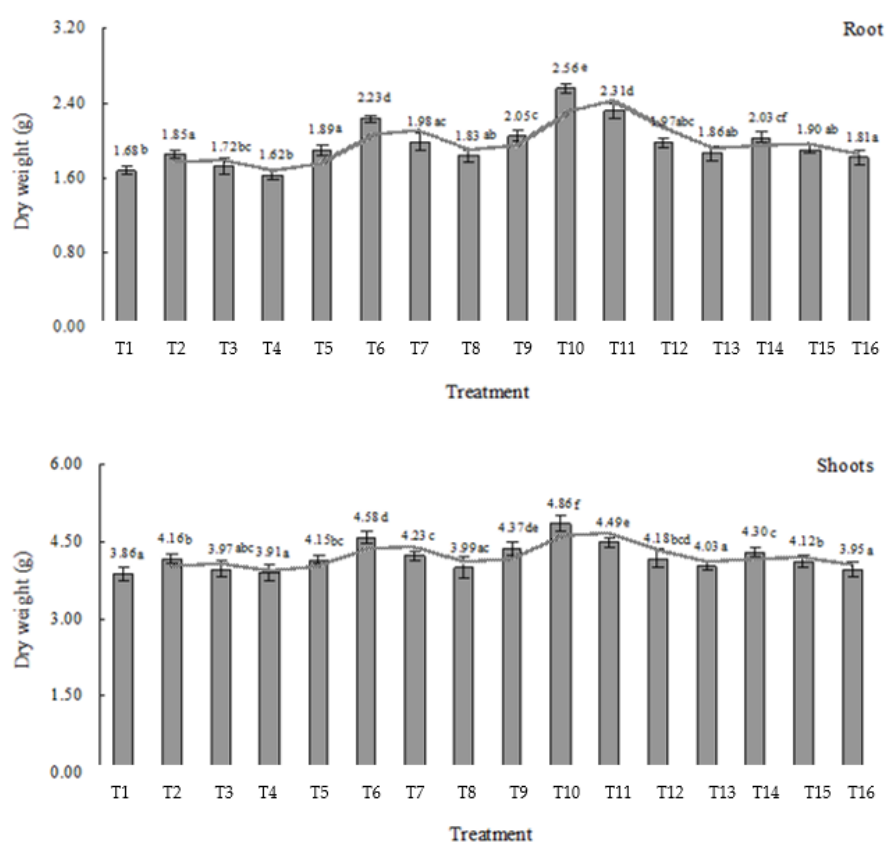
Figure 3. The effect of electric field on root and shoots biomass dry weight (g) of L. japonica . Values represent mean ± SD. Different letters indicate significant differences at the 5% level according to the LSD test.